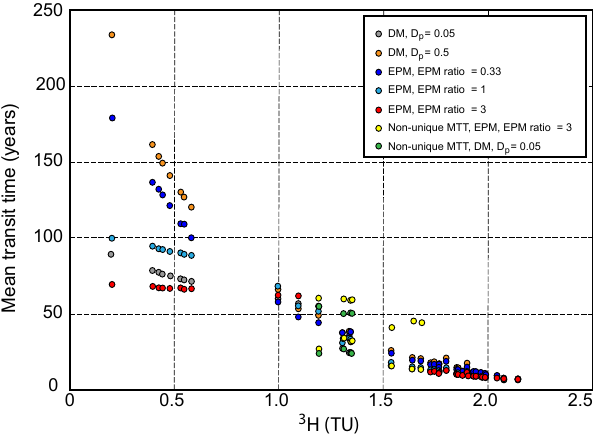
Figure 7. Estimated MTTs vs. 3 H activities in the stream waters cal- culated using the exponential piston-flow model (EPM) with EPM ratios of 0.33, 1.0, and 3.0 and the dispersion model (DM) with D p values of 0.05 and 0.5. Data from Supplement and Table